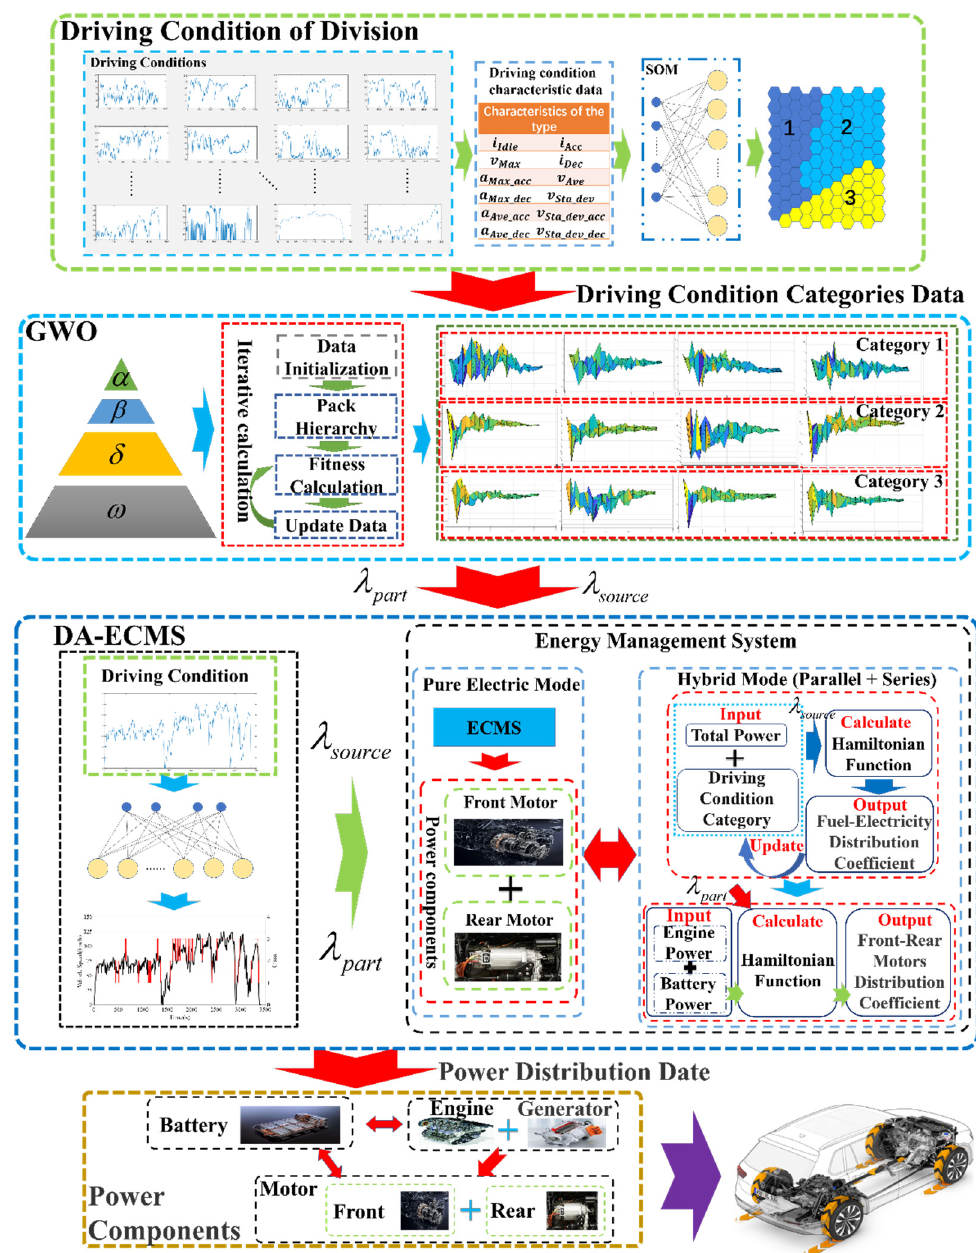
Figure 5. Illustration of the energy management strategy process.